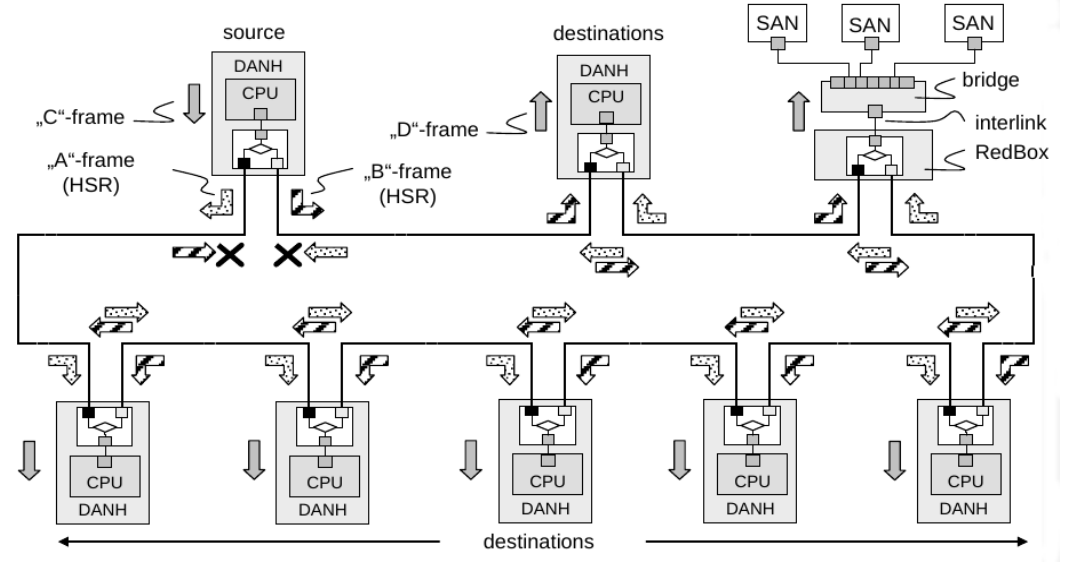
Figure 2. HSR (High-availability Seamless Redundancy) basic topology. Multicast frame example